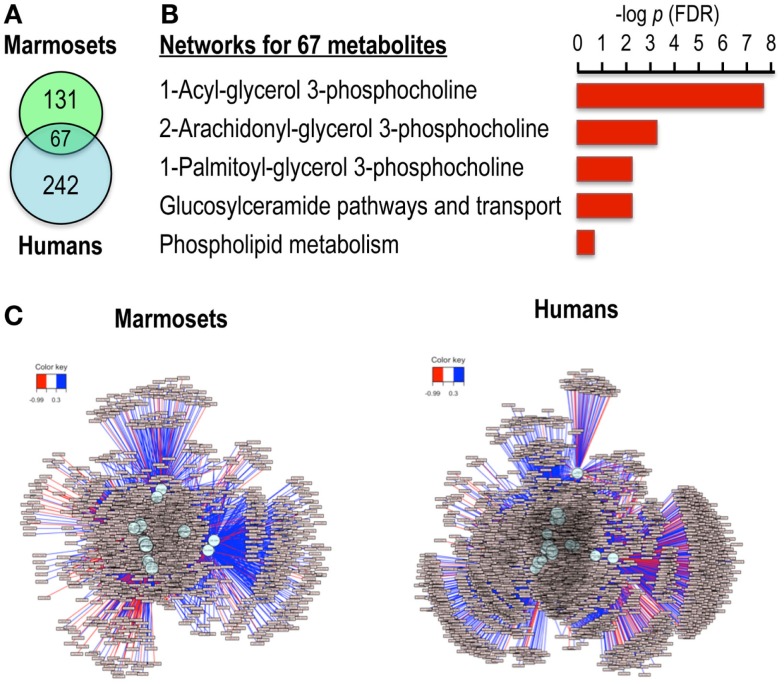
Ions correlated with choline in both marmoset and human samples map to phosphocholine pathways in network enrichment analysis. (A) Venn diagram shows 67 ions were common among the 198 correlated ions for marmosets and 309 correlated ions for humans. (B) Analysis of these 67 ions by MetaCore showed significant pathway enrichments after FDR correction for multiple phosphocholine pathways. (C) Metabolome-wide network structure. Correlation analyses showed that 18 of the 67 ions had similar pairwise correlation patterns for marmosets and humans at p < 0.05. These were tested for correlations among other ions, and features that had absolute Spearman correlation >0.3 at FDR <0.05 are shown for marmosets and humans, demonstrating ability to map the broader network structure associated with choline. Stratification according to strengths of associations showed that the most highly associated clusters contained phospholipids, while terpenoids and steroids were present in less strongly associated clusters.